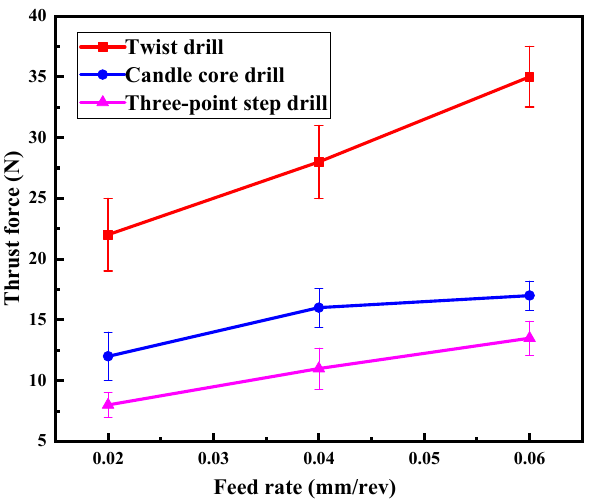
Figure 11. Thrust force curves of drills. Figure 12. Curve of cutting force with feed rate.